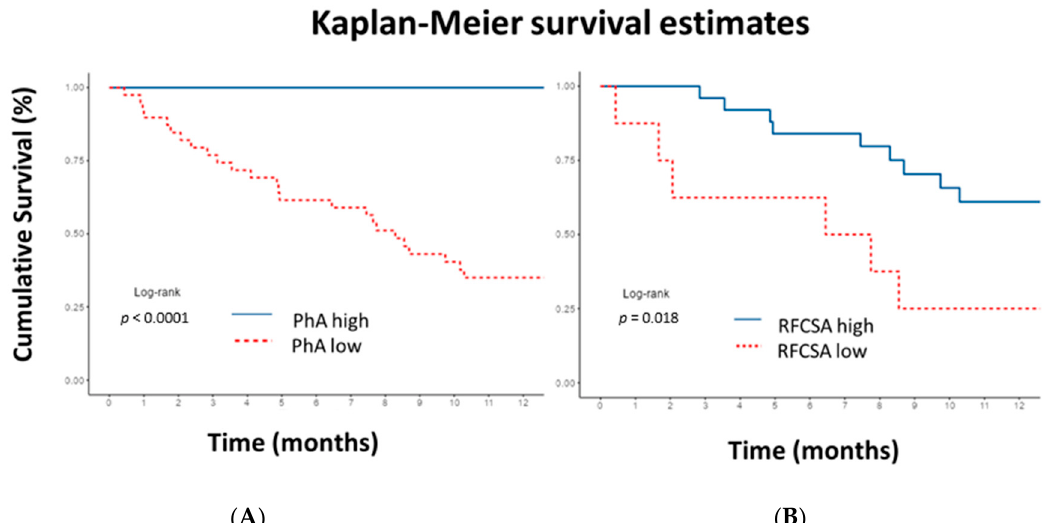
Figure 6. Kaplan–Meier 12-month survival plot illustrating cumulative survival for patients. ( A ) Low phase angle (PhA) in men <5.9° and in women <5.3°. ( B ) Low rectus femoris cross-sectional area (RFCSA) in men <4.47 cm 2 and in women <2.73 cm 2 . Cut-off values obtained by receiver operating characteristic curve. p -values for log-rank test. A significantly lower survival rate was observed in patients with lower PhA and RFCSA cut-off values. To interpret the color references in this figure legend, please see the Web version of this article.